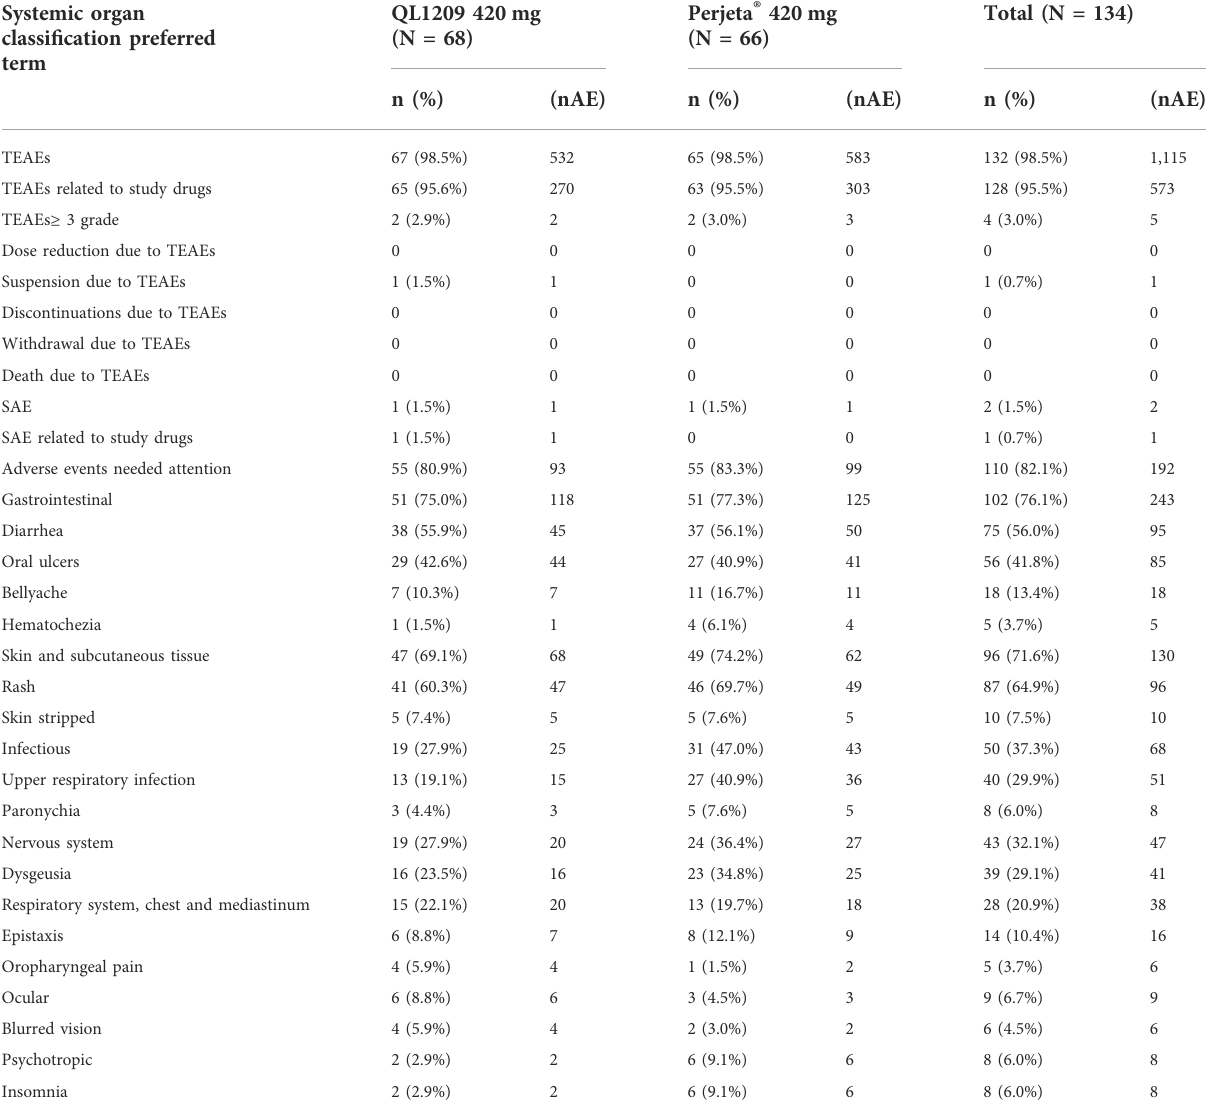
TABLE 4 Summary of treatment-emergent adverse events and drug-related TEAEs by category in part-2. Systemic organ classi fi cation